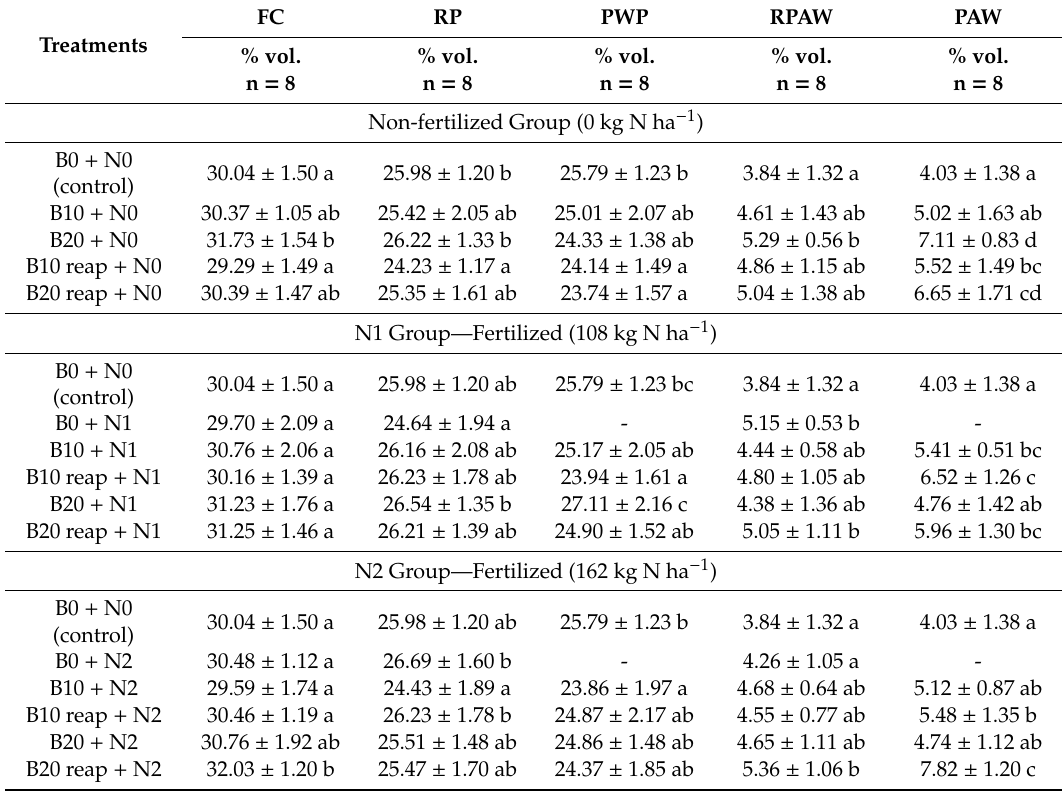
Table 6. E ff ect of biochar application and re-application on basic water limits (means ± standard deviations). Di ff erent letters indicate that treatment means are significantly di ff erent at p < 0.05 according to least significance di ff erence